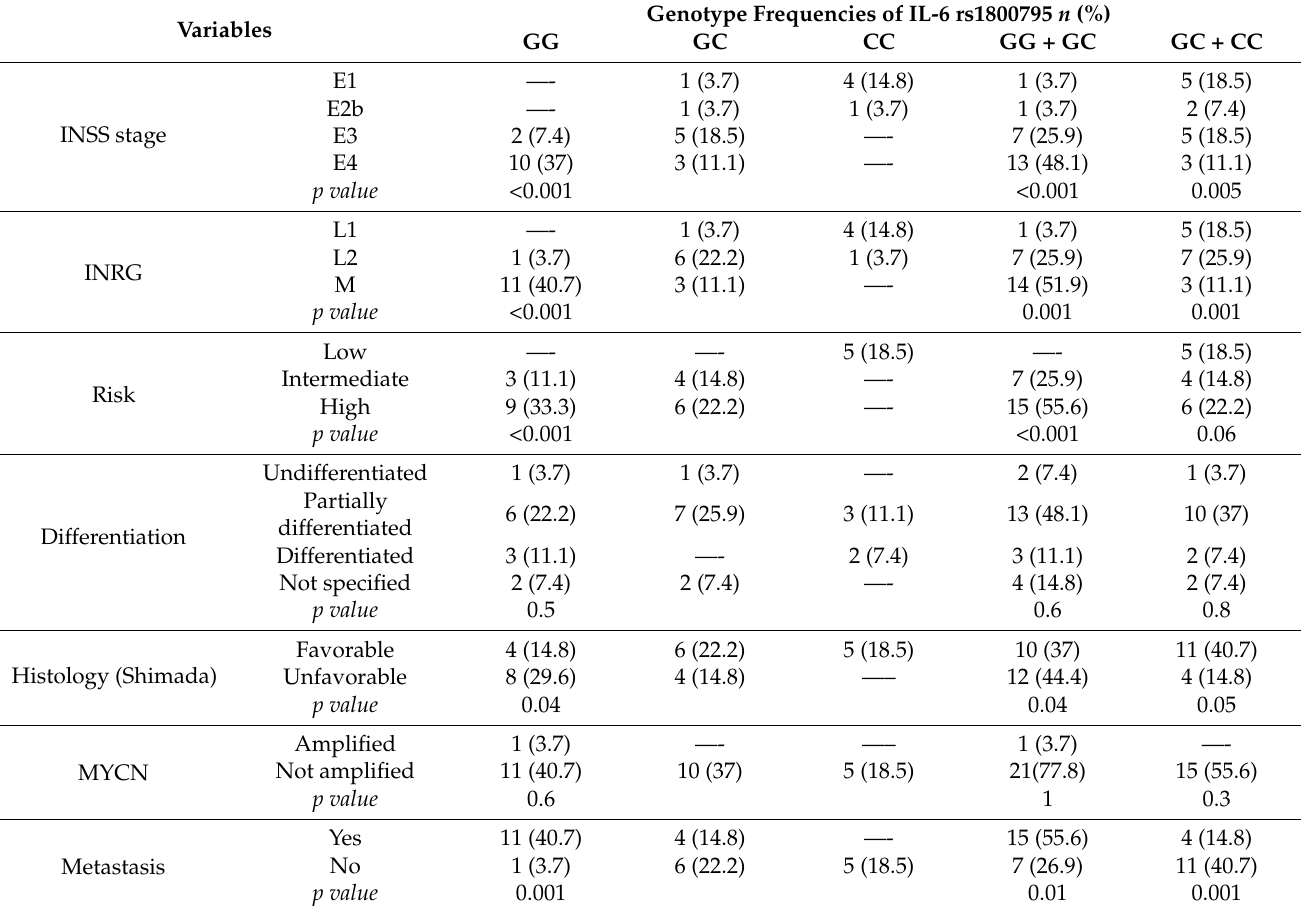
Table 3. Genotype frequencies of the gene IL-6 − 174 G > C rs1800795 and prognostic factors of NB